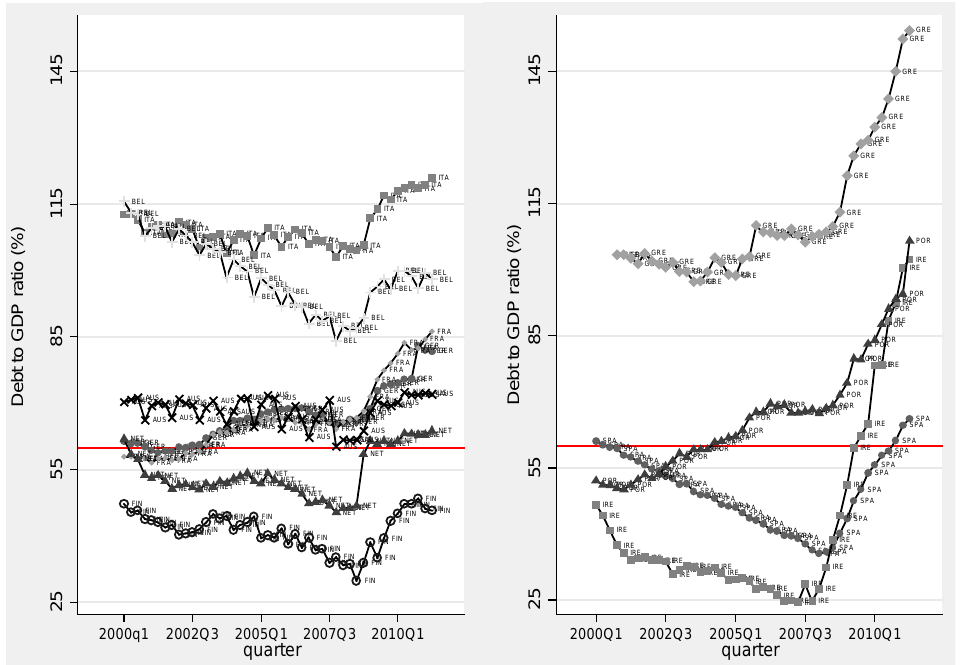
Figure 1. Debt-to-GDP ratio in Economic and Monetary Union (EMU)